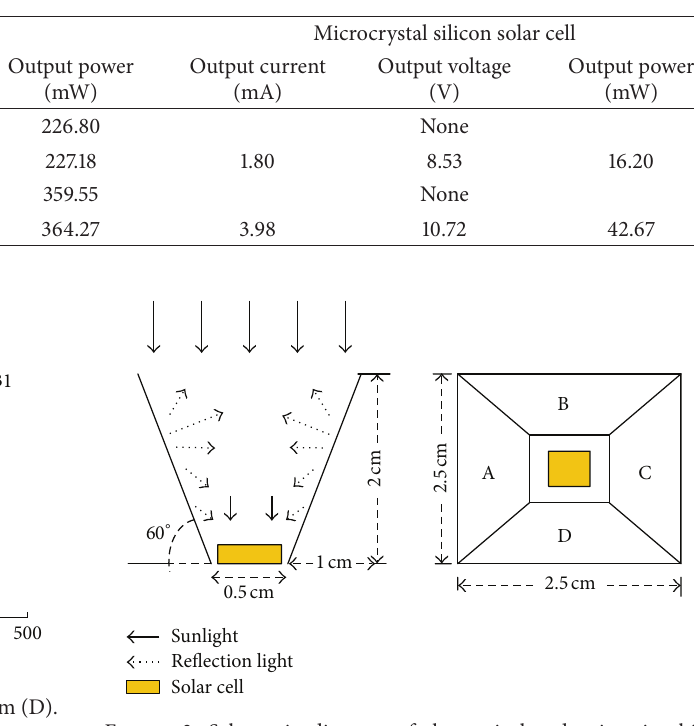
Figure 3: Schematic diagram of the optical rod prism in this research work and Table